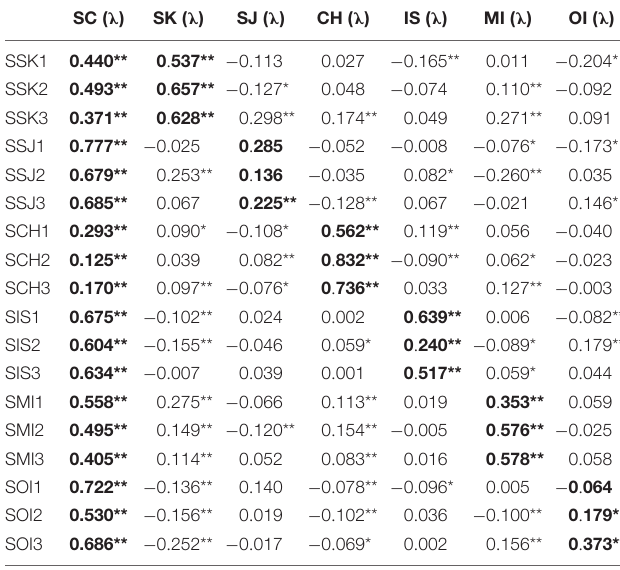
TABLE 1 | Goodness-of-fit indices for the estimated solution for the Japanese version of the State Self-Compassion Scale in Study 1. Models